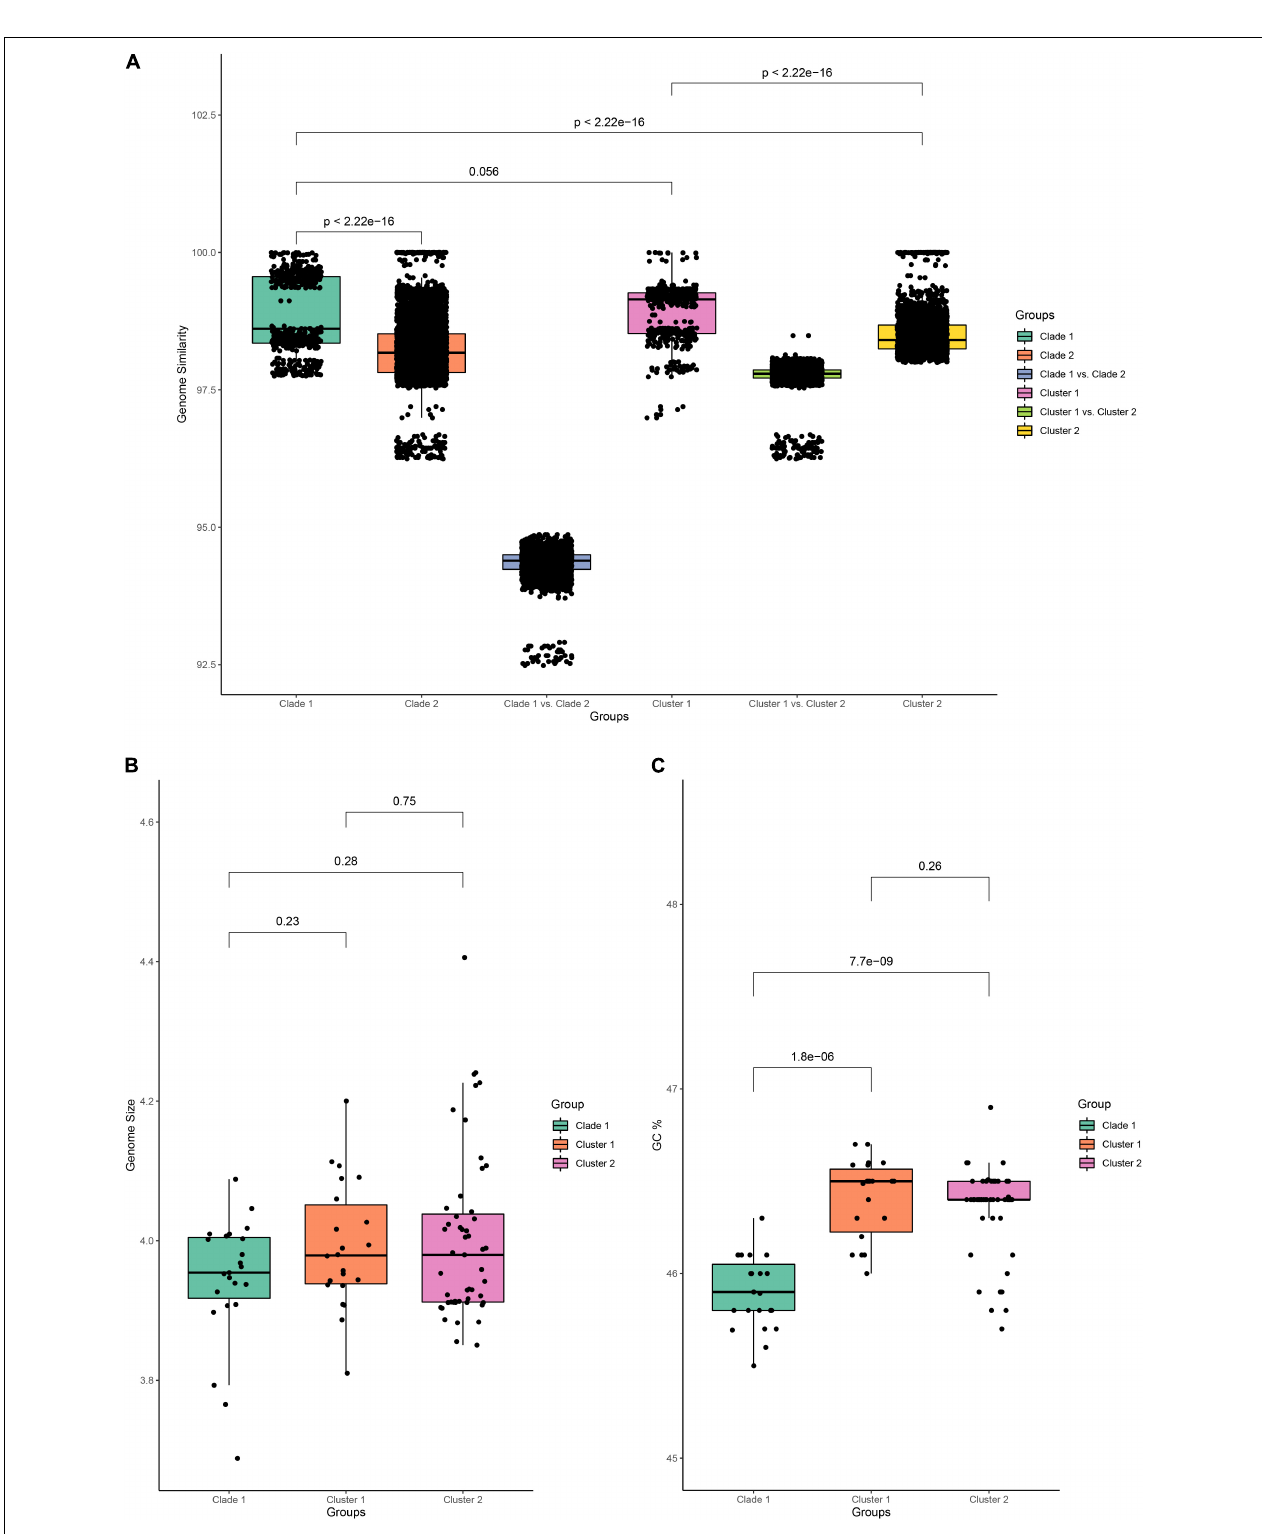
FIGURE 3 | Genome feature of B. amyloliquefaciens . (A) Genome similarity between all pairs of strains in clade 1, between all pairs of strains in clade 2, between strains in clade 1 and those in clade 2, between strains in cluster 1, between strains in cluster 2, and between strains in cluster 1 and those in cluster 2. (B) Genome size of clade 1 and cluster 1 and cluster 2 of clade 2. Wilcox test was performed and marked on top of the box plot. (C) GC percent of clade 1, cluster 1, and cluster 2 of clade 2. Wilcox test was performed and the p -value was marked on top of the box plot.